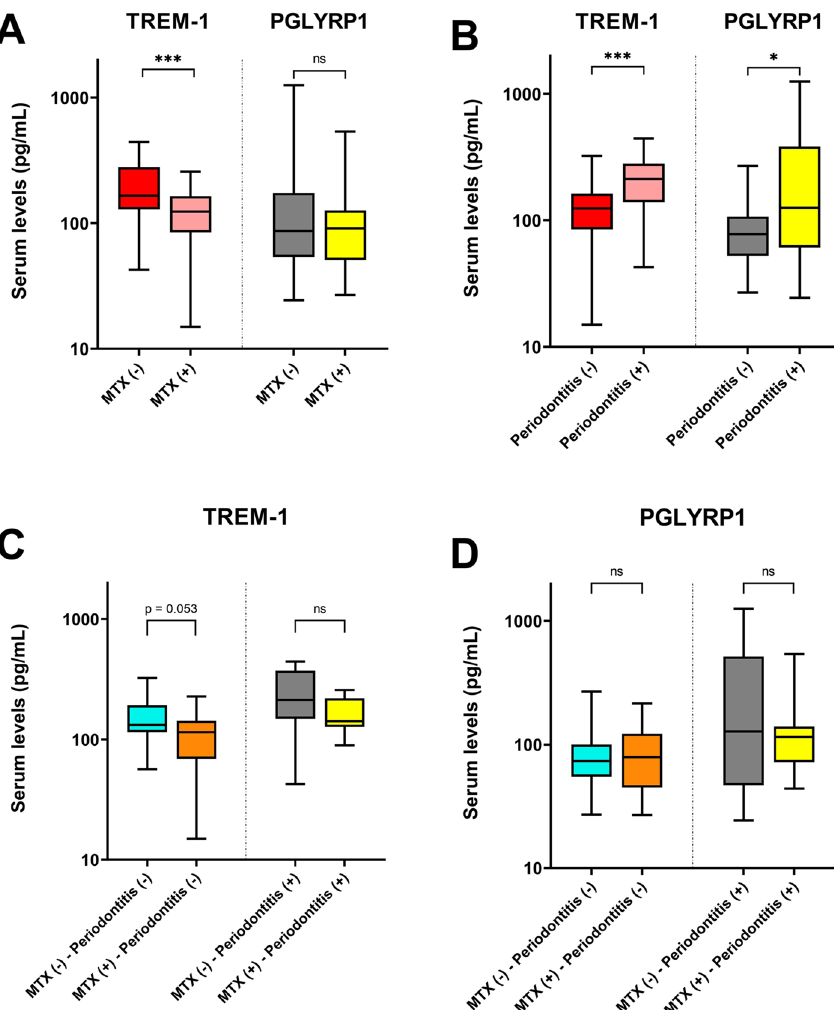
Figure 2. TREM-1 and PGLYRP1 serum levels in RA patients. ( A ) serum levels of TREM-1 and PGLYRP1 are compared between RA patients with and without MTX in their therapeutic regimen. ( B ) serum levels of TREM-1 and PGLYRP1 are compared between RA patients affected or not by periodontitis. ( C ) and ( D ) serum levels of TREM-1 and PGLYRP1 are compared between subgroups of RA patients clustered based on MTX use and presence of periodontitis. Boxplots show the first and third quartile (top and bottom edges of the rectangle) divided by the median. Whiskers correspond to the highest and lowest values. A base-10 log scale is applied on the y-axis. *p ≤ 0.05, **p ≤ 0.01, ***p ≤ 0.001. MTX methotrexate, ns